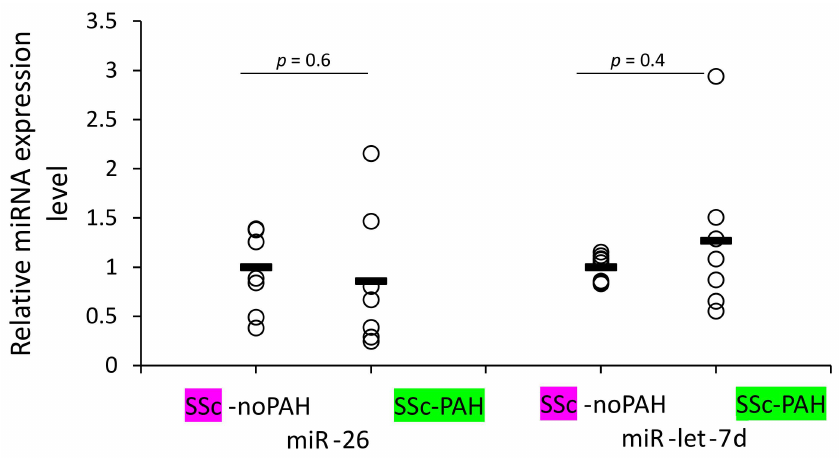
Figure 3. miR-26 and miR-let-7d levels in WBCs of SSc-noPAH and SSc-PAH patients. WBCs were isolated from 7 SSc-PAH and 8 SSc-noPAH patients. RNA was isolated from the cells and the levels of miR-26 and miR-let-7d were evaluated with qRT-PCR. miR-16 served as the normalizing miRNA. The graph represents miRNA expression levels relative to miR-16. Horizontal bars represent the mean values of the